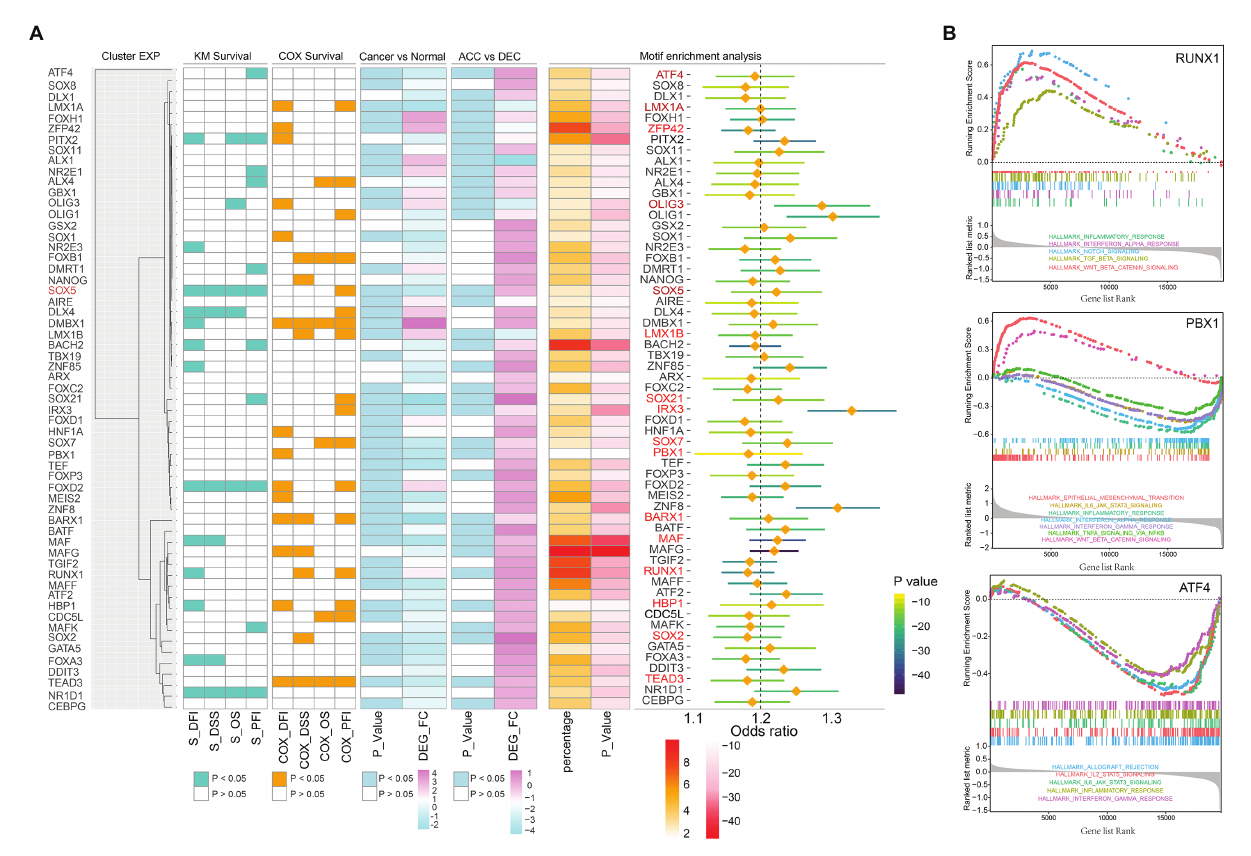
FIGURE 5 | The expression profiles and prognosis effect of enriched transcription factors (TFs) in TCGA STAD cohort. (A) Prognosis-associated TFs (including ATF4, LMX1A, ZFP42, OLIG3, SOX5, LMX1B, SOX21, IRX3, SOX7, PBX1, BARX1, MAF, RUX1, HBP1, SOX2, and TEAD3) and differential expressed genes were showed on the left side of the figure; enriched TFs and related odds ratio values were showed on the right side of the figure. (B) GSEA identified TFs including RUNX1, PBX1, and ATF4 were significantly enriched in immune-related pathways. The genes were ranked by log 2 fold change. DEG, differential expression genes; OS, overall survival; DSS, disease specific survival; PFI, progression free interval event; DFI, disease free interval event; S, results of Kaplan-Meier survival analysis; COX, results of univariate Cox regression analysis; ACC, DNAm age accelerated group; DEC, DNAm age decelerated group; STAD, stomach adenocarcinoma; TCGA, The Cancer Genome